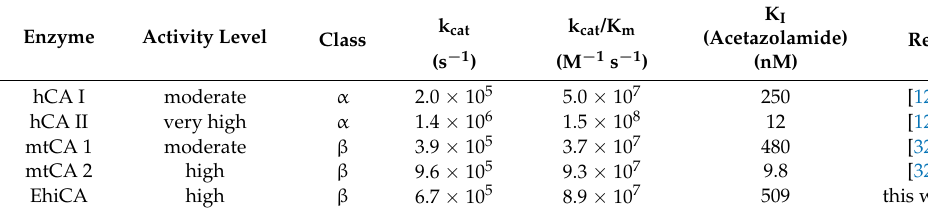
Table 1. Kinetic parameters for the CO 2 hydration reaction catalyzed by the human cytosolic isozymes hCA I and II ( α‐ class CAs) at 20 °C and pH 7.5 in 10 mM HEPES buffer and 20 mM Na 2 SO 4 , and the β‐ CA from M. tuberculosis (mtCA 1 and 2) and form E. histolytica EhiCA, measured at 20 °C, pH 8.3 in 20 mM TRIS buffer and 20 mM NaClO 4 . Inhibition data with the clinically used sulfonamide